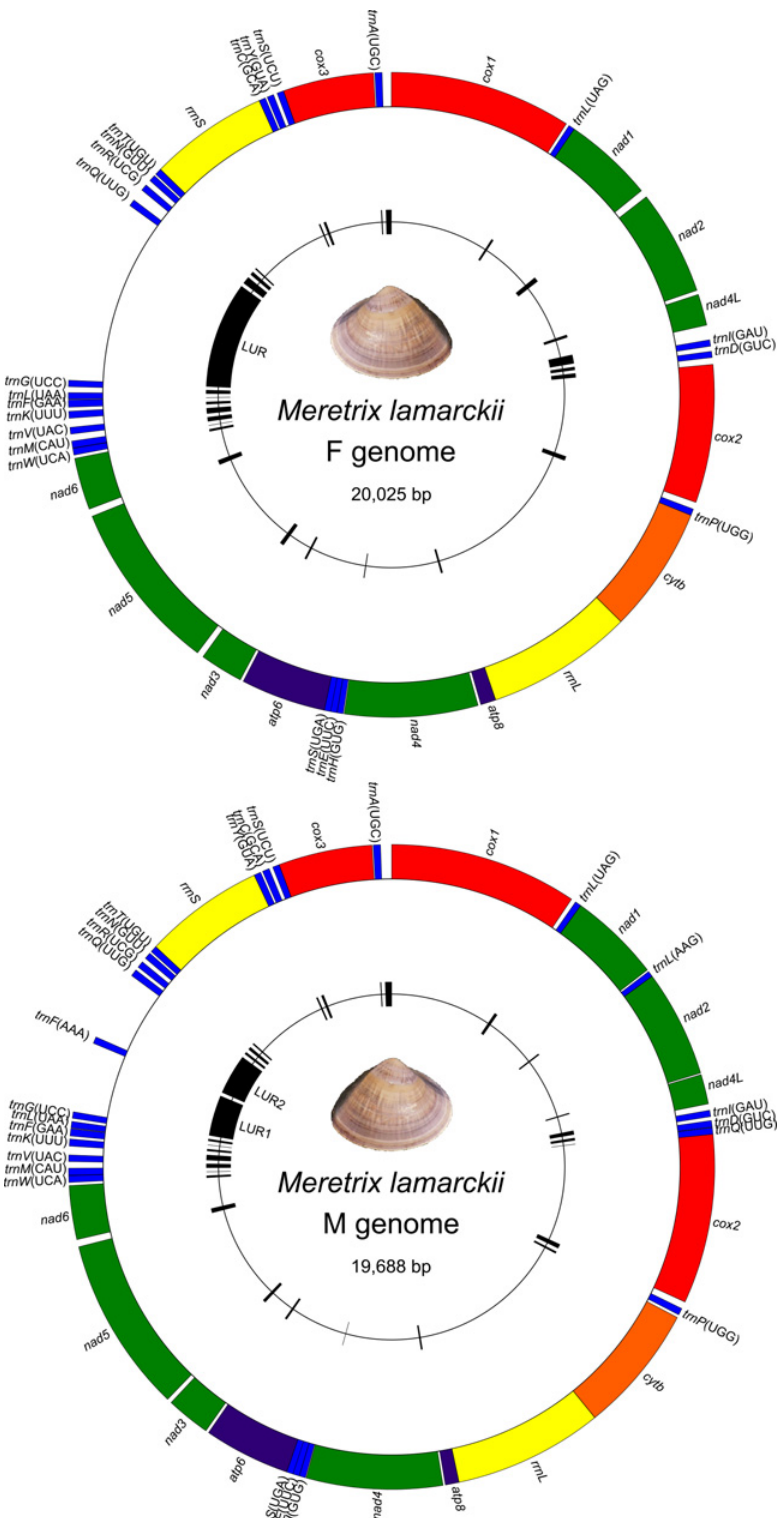
Fig 1. Meretrix lamarckii sex-linked mitochondrial genomes. Genomic map of F- (above) and M- (below) mtDNA of Meretrix lamarckii starting from cox1 . Genes are all on "+" strand; genome lengths are shown in the middle of each map. Unassigned Regions (URs) are reported in black in the internal circle. doi:10.1371/journal.pone.0153631.g001 PLOS ONE | DOI:10.1371/journal.pone.0153631 April 15,